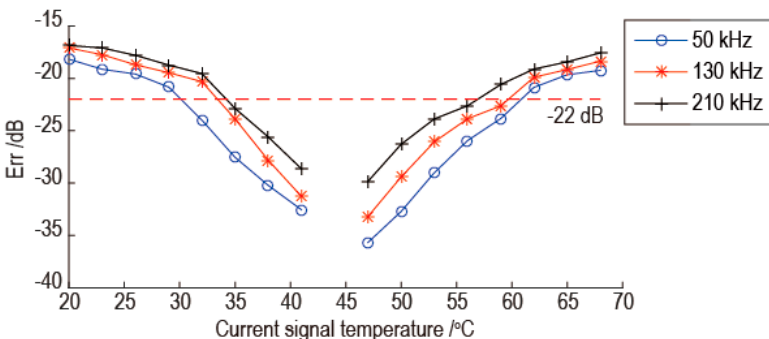
Figure 6. The temperature compensation results using 44 °C baseline signal and 47 °C reference signal.